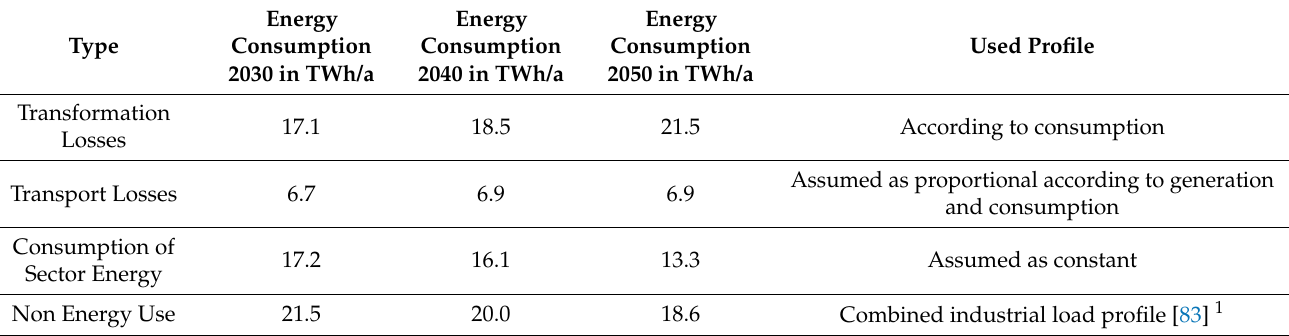
Table A11. Consumption of the energy supply system for the scenario Sufficiency final energy (based on [40]).